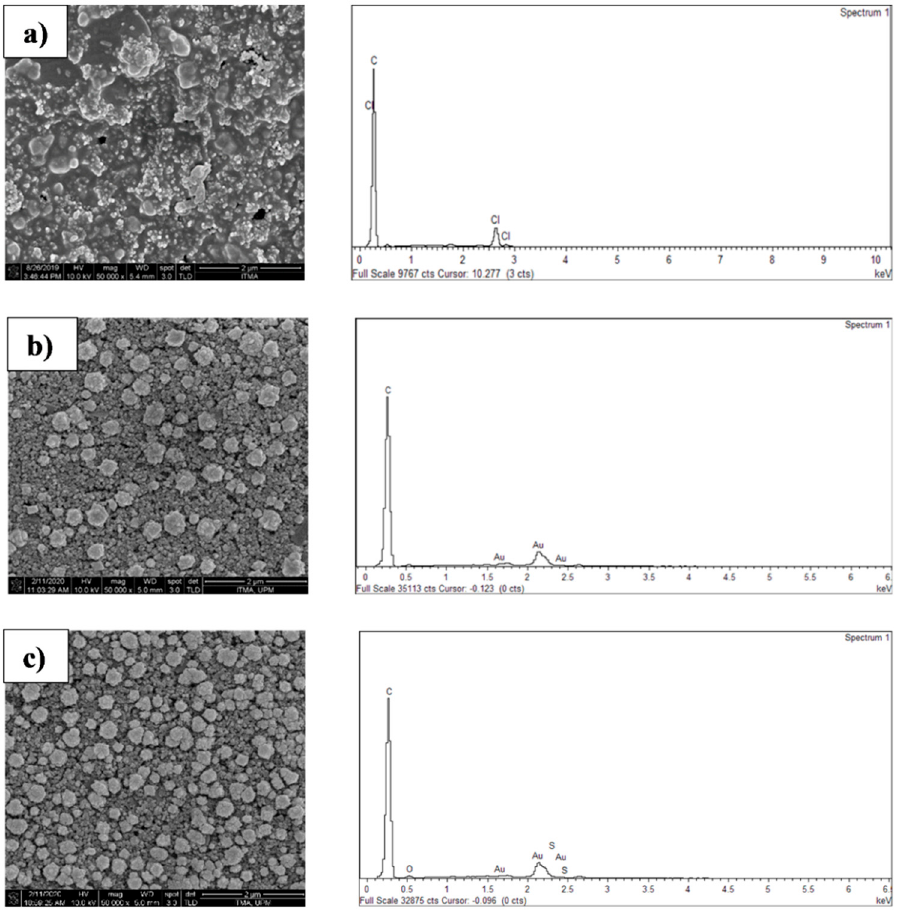
Figure 2. FESEM images and EDX graphs of ( a ) bare screen-printed carbon electrode (SPCE), ( b ) AuNPs/SPCE, and ( c ) TC4/AuNPs/SPCE.